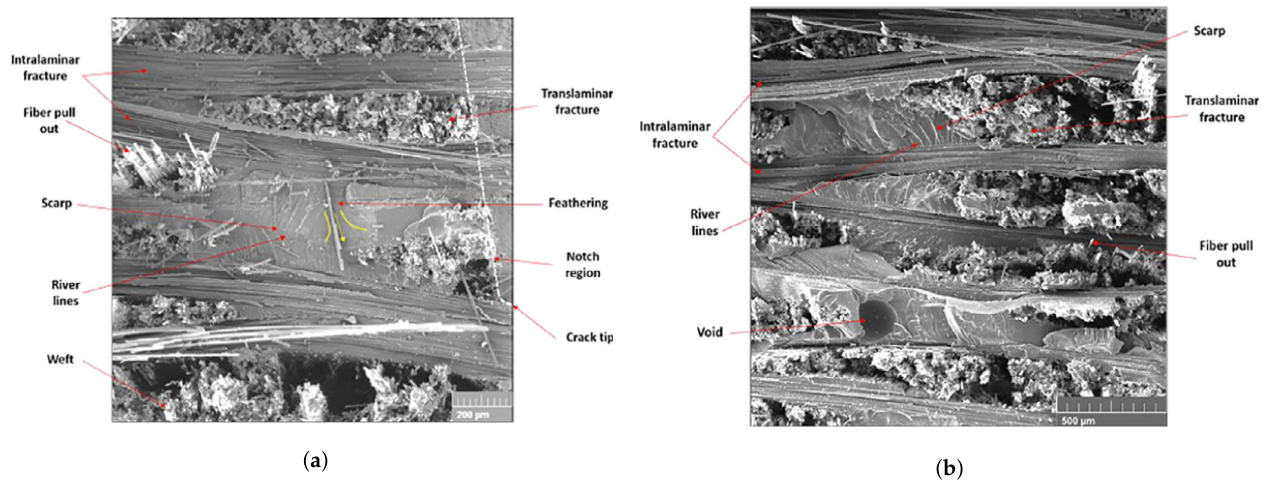
Figure 3. ( a ) The fracture surface of the specimen tested in the quasi-static regime with magnification of 150 × . ( b ) Details on the transverse fibers of the specimen tested at strain rate of =245 s with magnification 110 ×